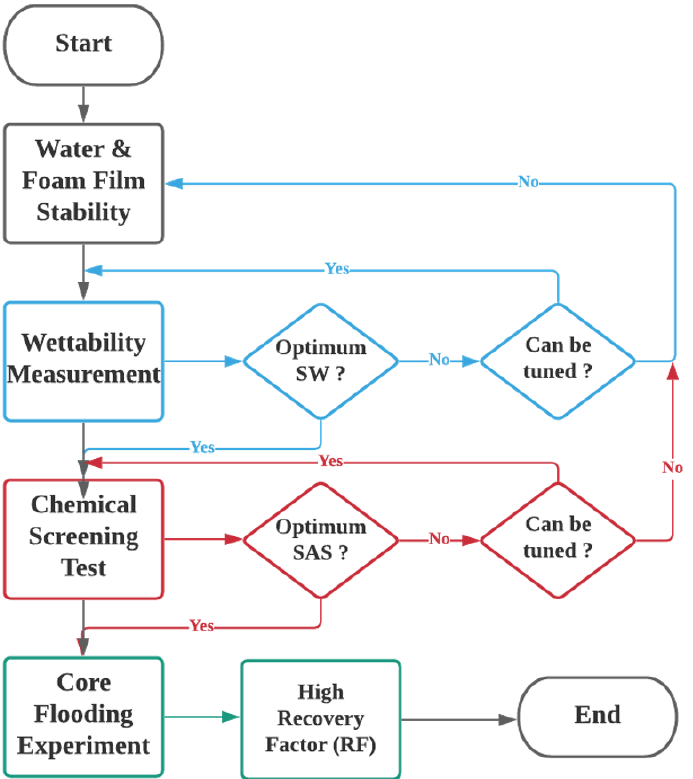
Figure 2. Flow chart of the systematic experimental design used to investigate and optimize smart water-assisted foam (SWAF) flooding process on the laboratory scale. No means “still considering for the best option”; Yes, means “the best option achieved”.